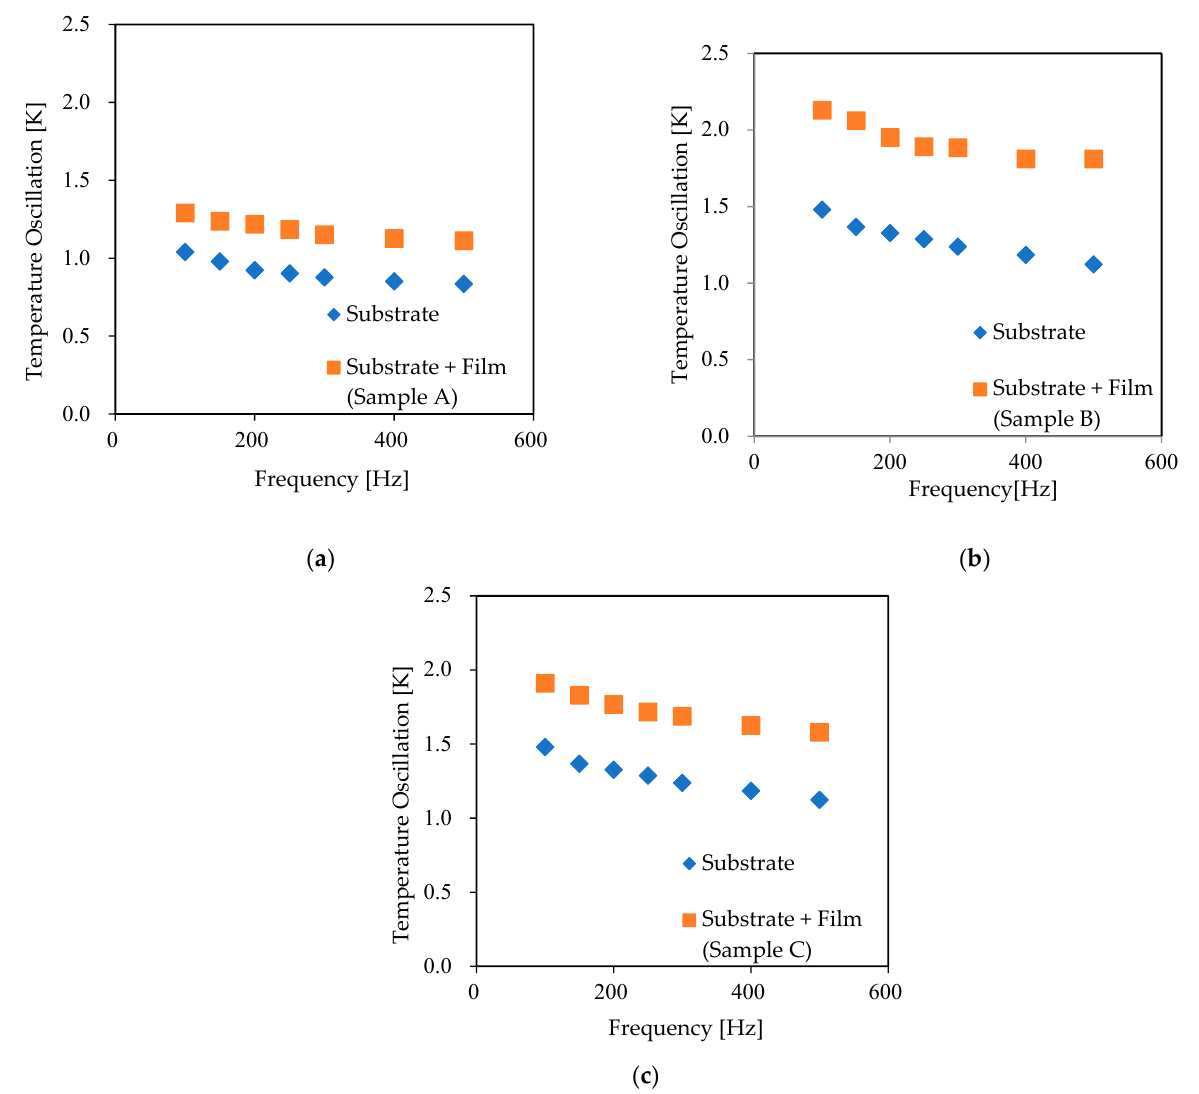
Figure 4. Temperature oscillation amplitude of ( a ) Sample A, ( b ) Sample B, and ( c ) Sample C at room temperature.